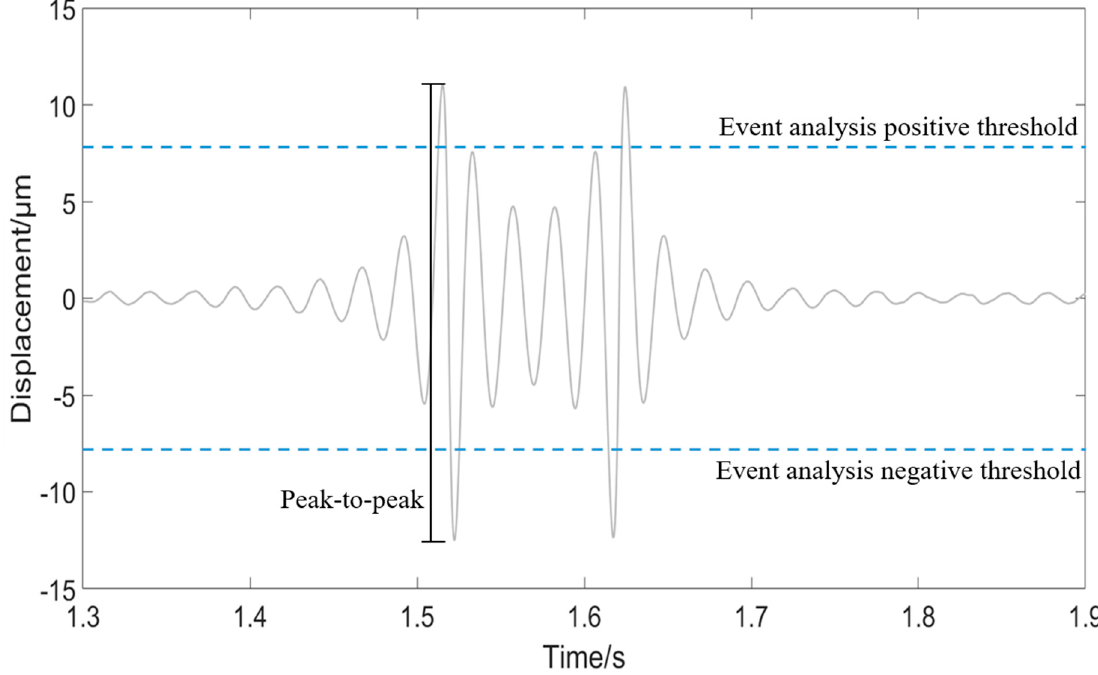
Figure 4. Event analysis plot to investigate the dynamic behaviour around the area of interest, which is identified by the peak above the user defined threshold (dashed line), with the peak-to-peak analysis also